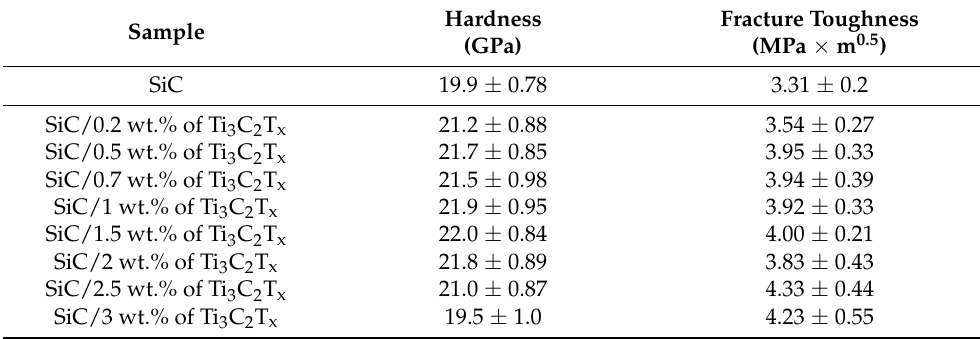
Table 1. Mechanical properties of the obtained